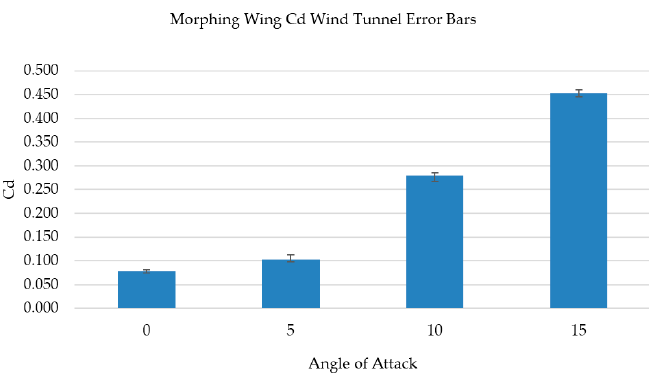
Figure 10. Morphing wing drag coefficient wind tunnel error bars.